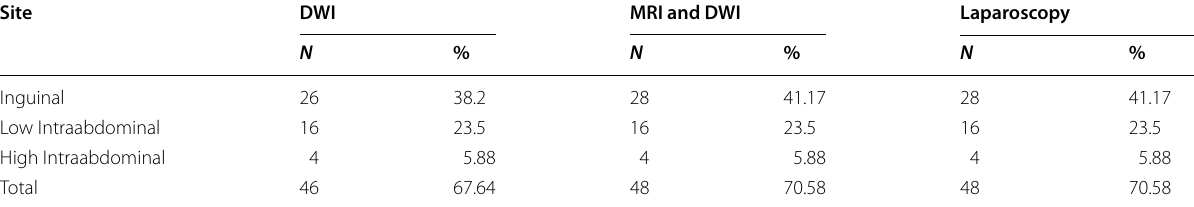
Table 6 Viability of detected undescended testes